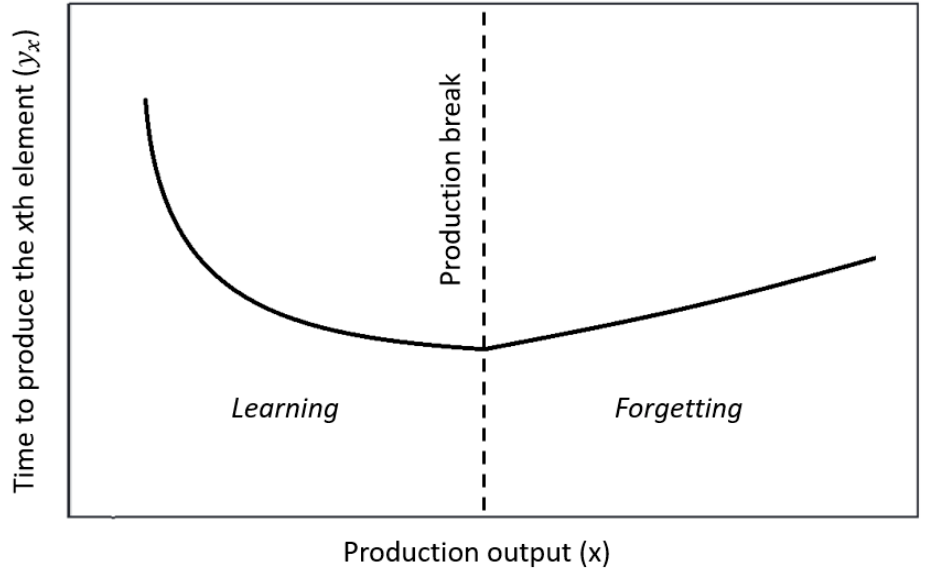
Figure 1. Sample learning and forgetting process.